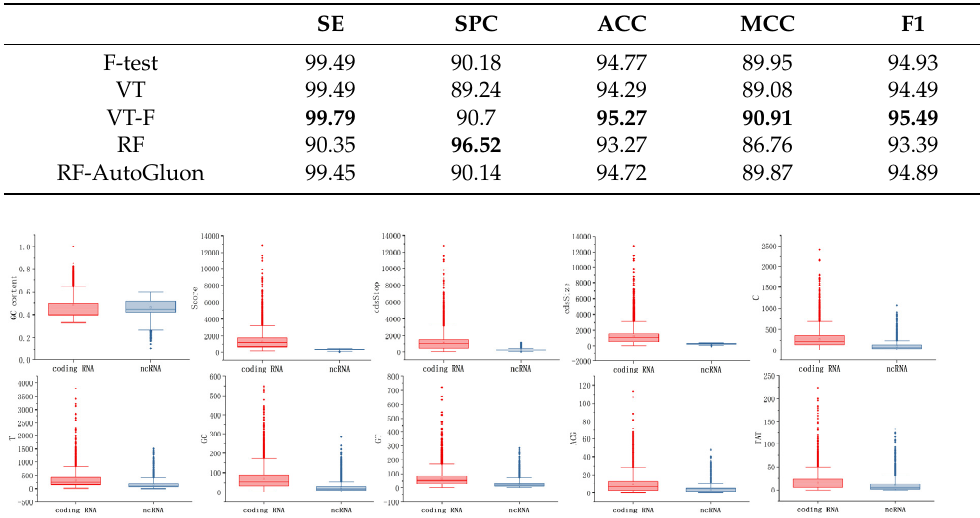
Figure 2. Differential distribution of ten features in coding RNAs and ncRNAs.